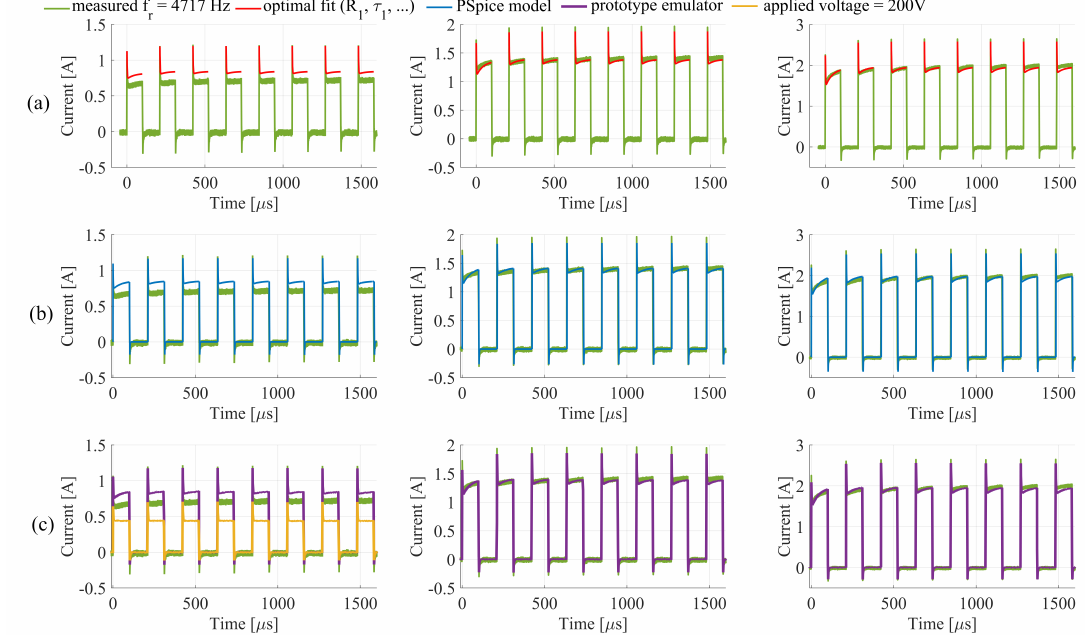
Figure 4. Average of five current measurements at 4717 Hz repetition frequency (green), ( a ) numerically modeled current by Matlab (red, first row), ( b ) modeled current by a PSpice (blue, second row) and ( c ) measured current trough prototype emulator (purple, third row). An additional current measurement in the case of the emulator was added at the applied voltage set to 200 V, in order to present a current response, when the applied voltage is lower than the threshold voltage. In the first column, the current at 500 V in the second 750 V and third 1000 V applied voltage amplitude is presented.